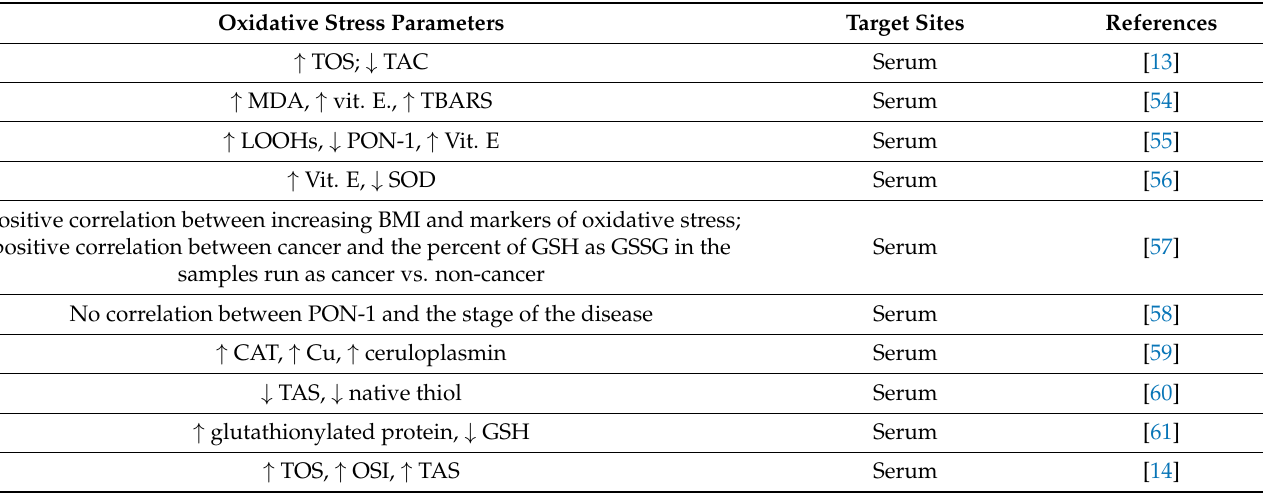
Table 1. Antioxidant capacity in endometrial